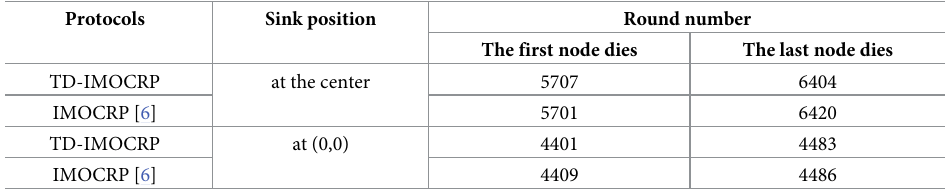
Table 2. Comparison results of network